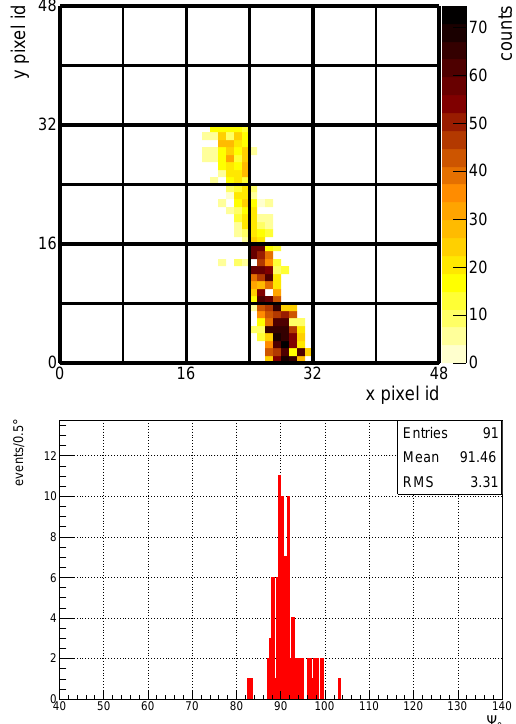
Figure 5. Left: Example of a laser track detected by EUSO- Balloon. Right: Zenith angle reconstruction of the helicopter laser shots with the 2-parameter fit method and laser energy of 15 mJ